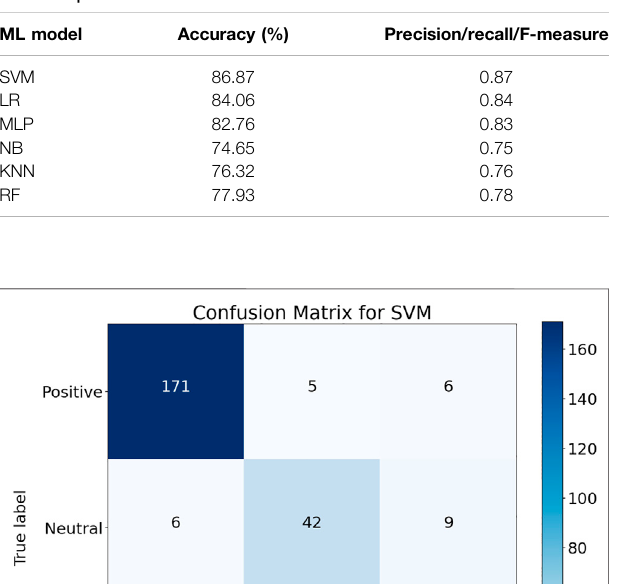
TABLE 1 | Performance results for ML models.